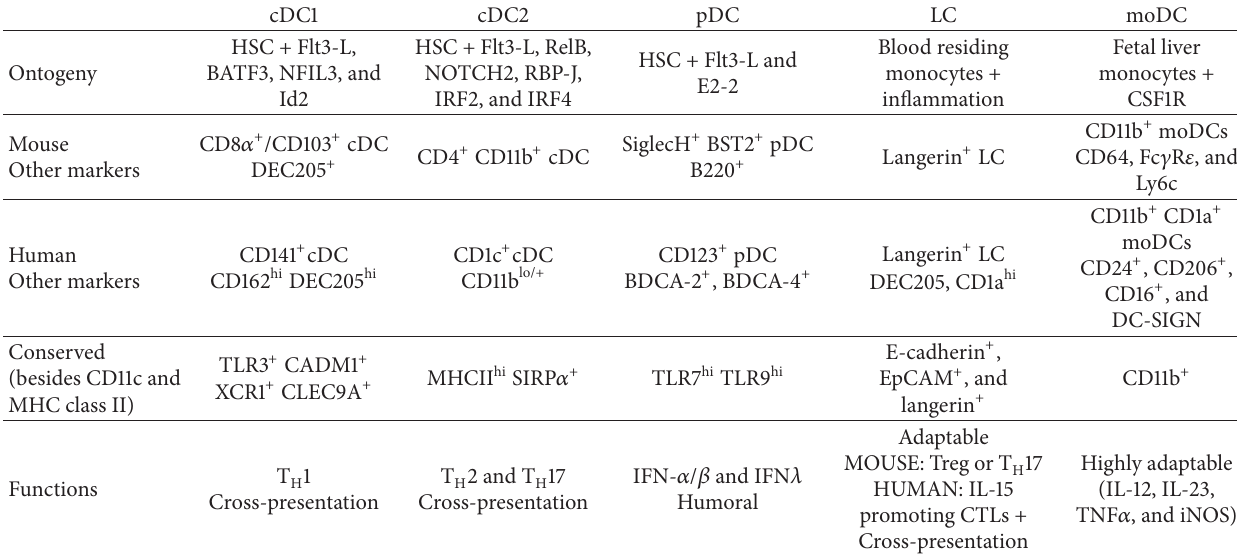
Table 1: Concise overview of the ontogenic, phenotypic, and functional features of the five main DC subtypes: cDC1, cDC2, pDC, LC, and